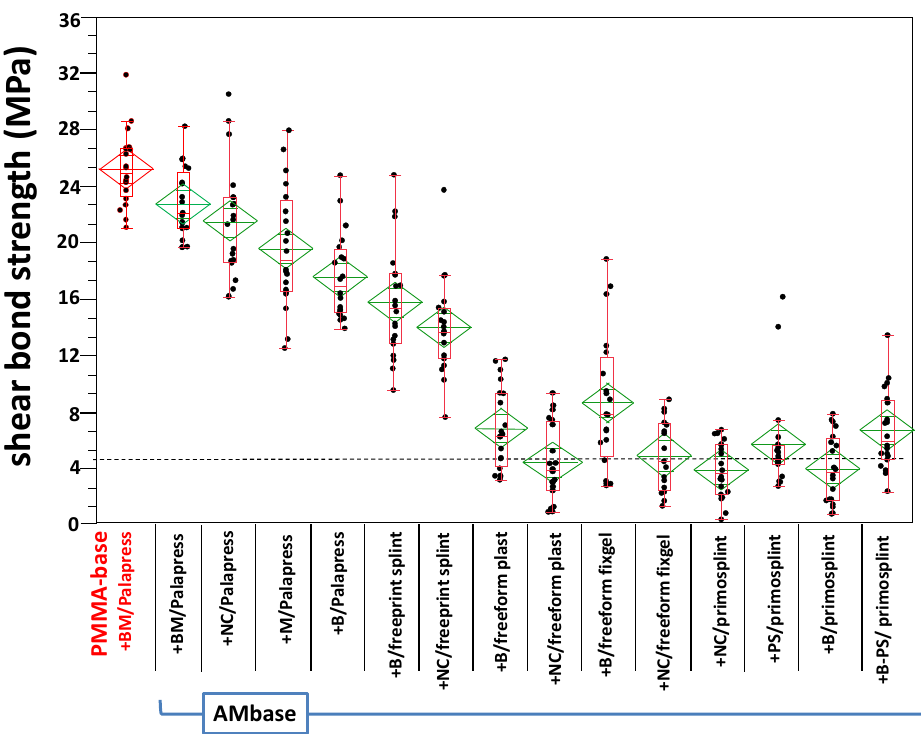
Figure 7. Box-plot of the shear bond strength values within the experimental groups after dry storage. The gold standard (PMMA) is plotted on the left (marked red). The boxplots with median values are supported by mean diamonds with 95% confidence intervals. The dashed horizontal line gives the threshold of 5 MPa defined by the standard (ISO 10477).